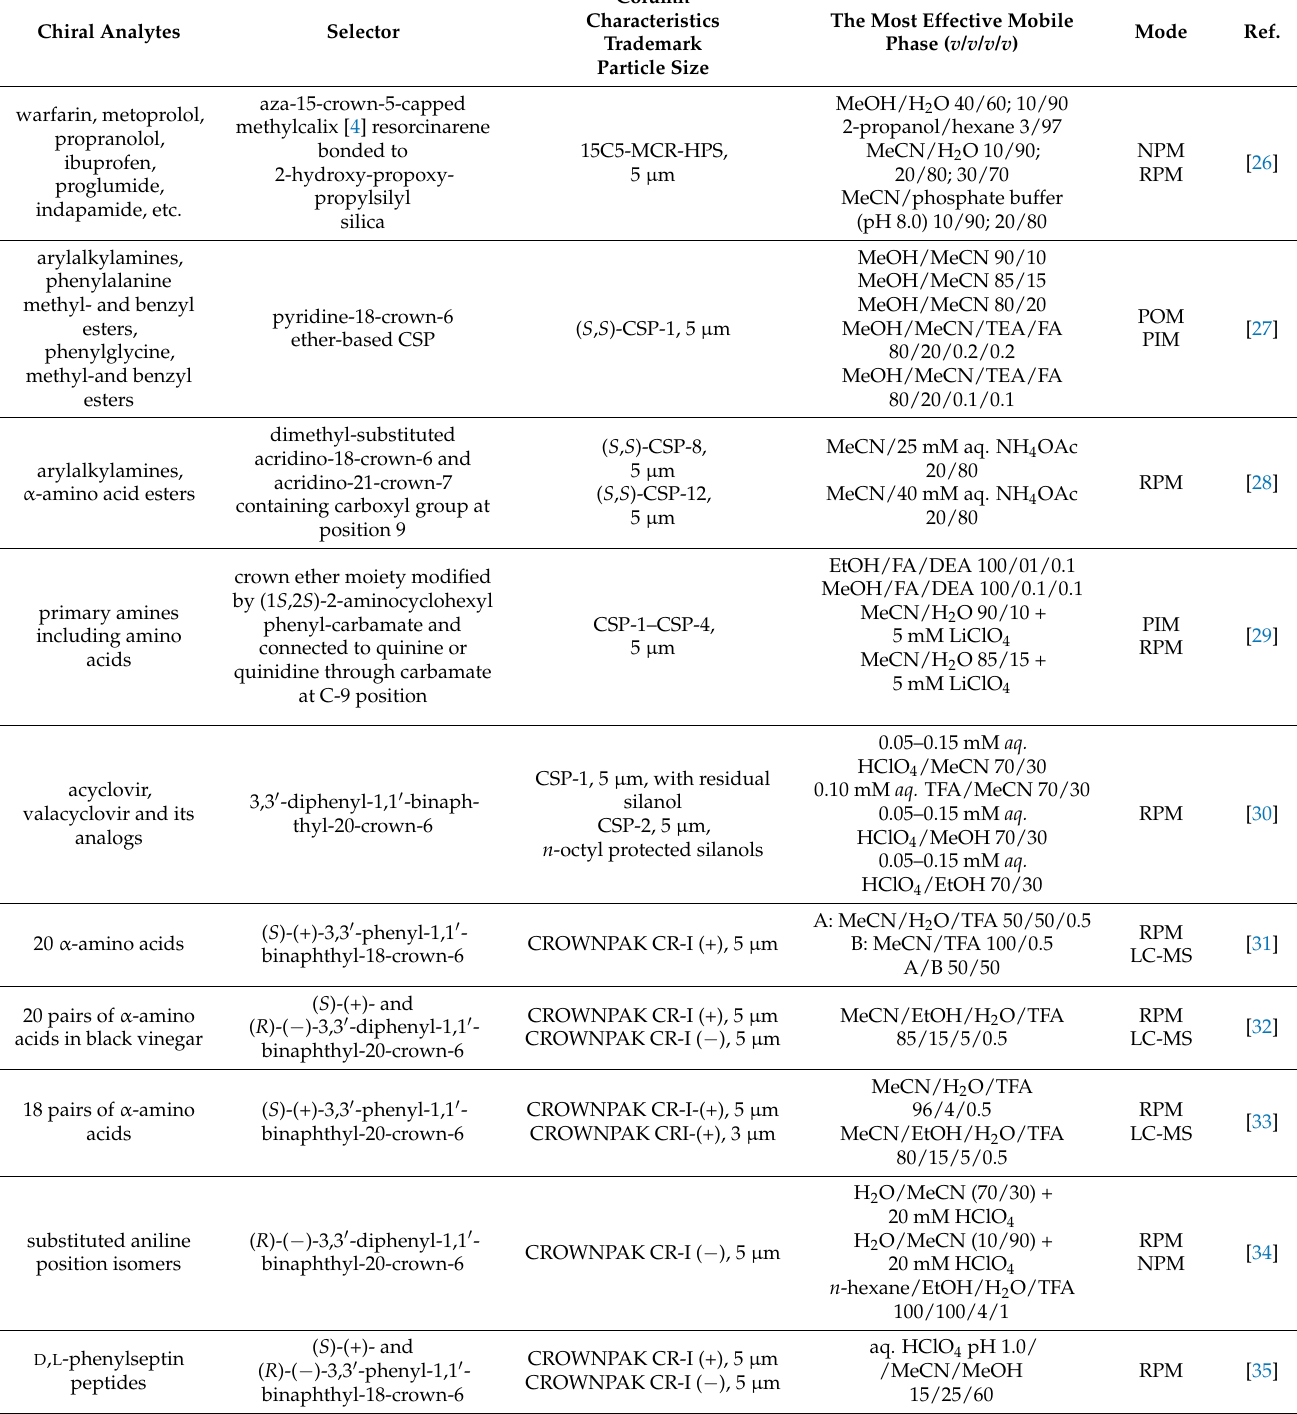
Table 2. High-performance liquid chromatographic enantioseparations on crown-ether-based chiral stationary phases 1 .